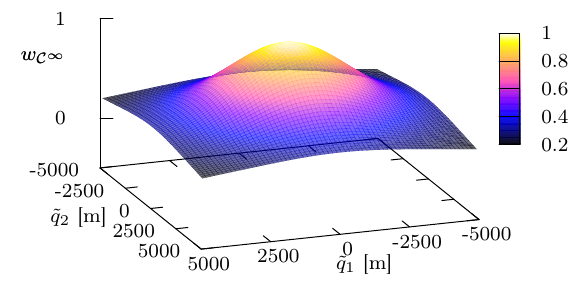
Figure 5: A smooth sampling function. The axes rep- resent col(˜ q 1 , ˜ q 2 ) = ˜ q = ( q − (cid:37) ), which is the relative planar coordinate between an object and a